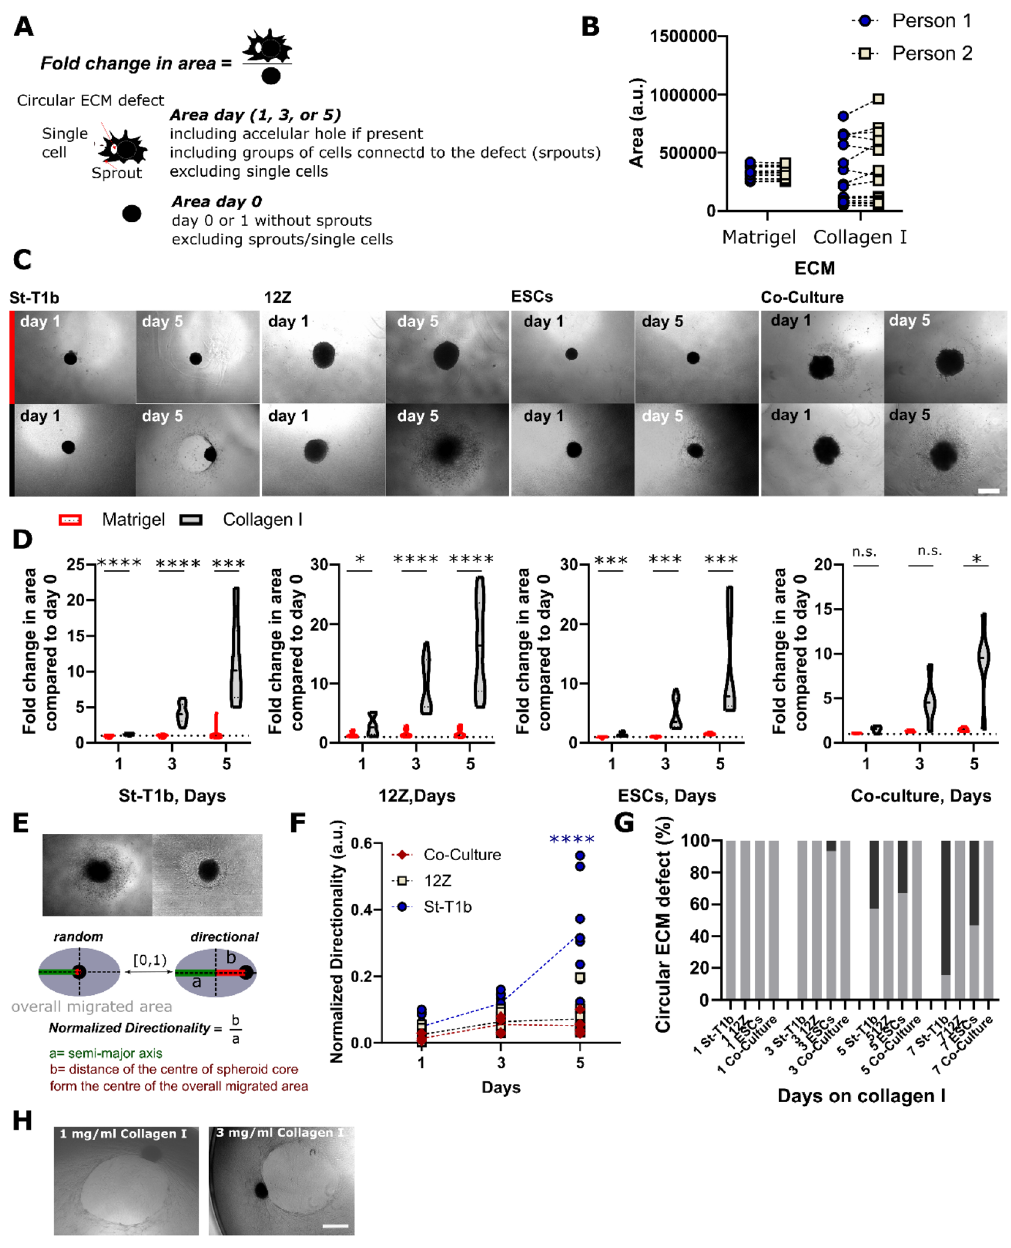
Figure 4. Quantification of spheroid behaviour on Matrigel and collagen I. ( A ) Schematic illustrating how the ‘Fold increase in the area’ was measured and calculated. ( B ) Validation of the manual measurement method showed no significant difference between different assessors following the defined criteria (n matrigel = 13, n collagen = 16, t test for each condition). ( C ) Brightfield images on day 1 and 5 of the spheroids on Matrigel (top row) and collagen I (bottom row). Scale bar 500 µm. ( D ) Quantification of the fold change in area for individual cell types and St-T1b:12Z co-culture (n = 12–15 independent wells per time point and condition collated from three independent spheroid preparations, n cocultures = 4–5, one preparation. Two-way Repeated Measures (RM) ANOVA, Šidák’s multiple comparisons tests). ( E ) Schematic illustrating how normalized directionality was calculated. ( F ) Normalized directionally for St-T1b (circles), 12Z (squares) and co-cultures (diamonds) on day 1, 3 and 5 (n = 5–10 wells per experiment collated from two independent preparations, n co-culture = 5 from one preparation). ( G ) Circular ECM defect quantification-grey colour represents the absence of macroscopic ECM defect and the black colour a presence of a circular defect (n = 13–15 independent wells collated from three separate spheroid preparations, n co-culture = 5 from one preparation. Two-way Repeated Measures (RM) ANOVA, Šidák’s multiple comparisons test) (H) Directional matrix remodeling resulting in a circular defect occured on both 1 mg/mL and 3 mg/mL collagen I hydrogels. For all figures in this panel *p < 0.05; **p < 0.01; ***p < 0.001, ****p < 0.0001, and n.s. p >